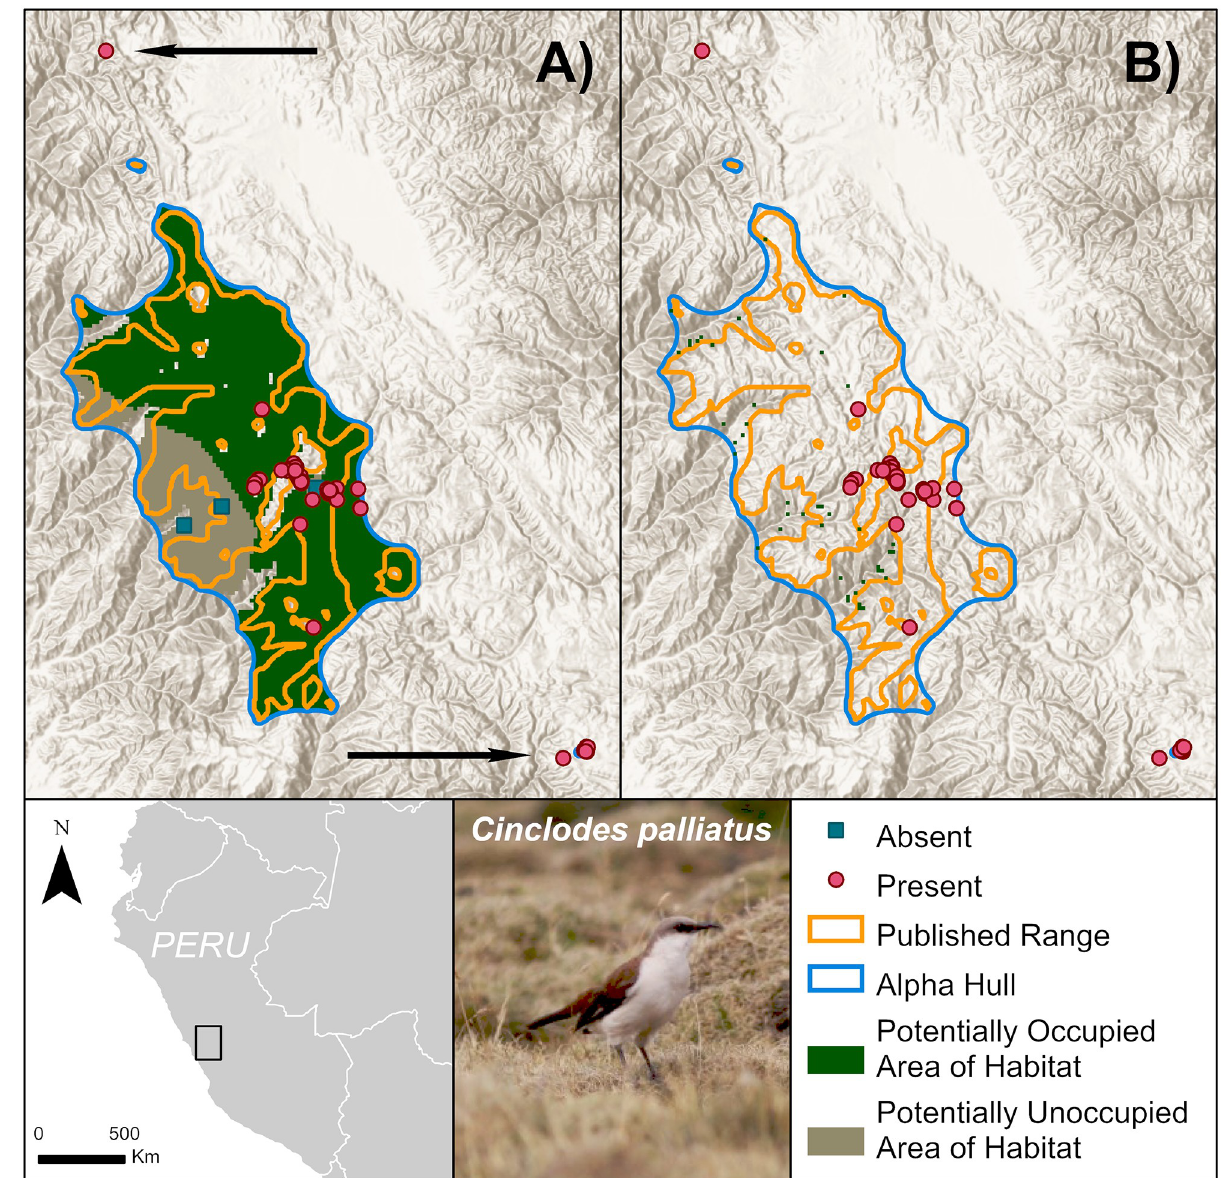
Fig 8. Limitations of refining Area of Habitat for white-bellied cinclodes, Cinclodes palliatus . (A) Estimates of Area of Habitat for species that prefer open land are often similar to the published ranges when refined just by the estimated elevational ranges. (B) Further refining a species range using forest cover—not a preferred habitat—may lead to a significant underestimation of Area of Habitat. Despite lack of appropriate landcover data to refine Area of Habitat, eBird records beyond the published range (identified with arrows) inform us that the range of these species is wider than recognised. Symbology is simplified to show absences (blues squares) as the centroids of absence grid cells. Basemaps provided by USGS and photos provided by Stuart Pimm with permission.